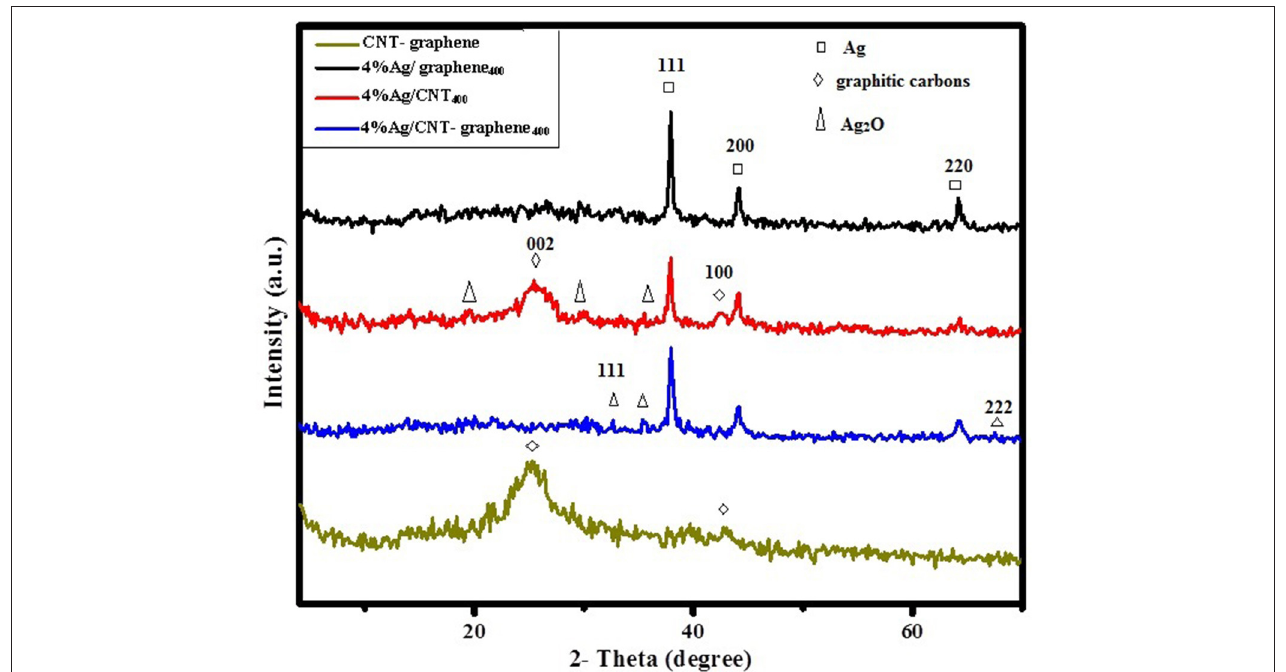
FIGURE 1 | XRD patterns of 4%Ag/graphene 400 , 4%Ag/CNT 400 , 4%Ag/CNT-graphene 400 , and CNT-graphene catalysts.